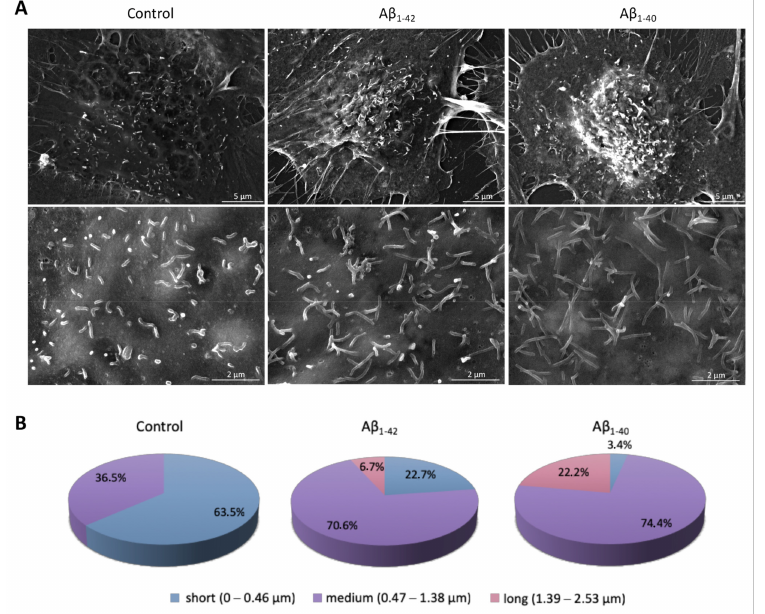
Figure 5. Morphological changes of endothelial microvilli after cell exposure to A β . ( A ) SEM-SE images of cell membrane protrusions formed by hCMEC/D3 cells under normal conditions or after incubation with 1 µ M of A β 1-42 or A β 1-40 oligomers for 24 h. Magnified views of microvilli (30kx) are shown in the lower panels. ( B ) Classification and distribution of endothelial microvilli according to their length in the different experimental conditions. At least 10 cells and 300–400 protrusions were analyzed for each condition. Measurements were performed using ImageJ software. Control: untreated cells; A β 1-42: cells exposed to A β 1-42 oligomers; A β 1-40: cells exposed to A β 1-40